Question: In a single sentence, describe what this figure presents.
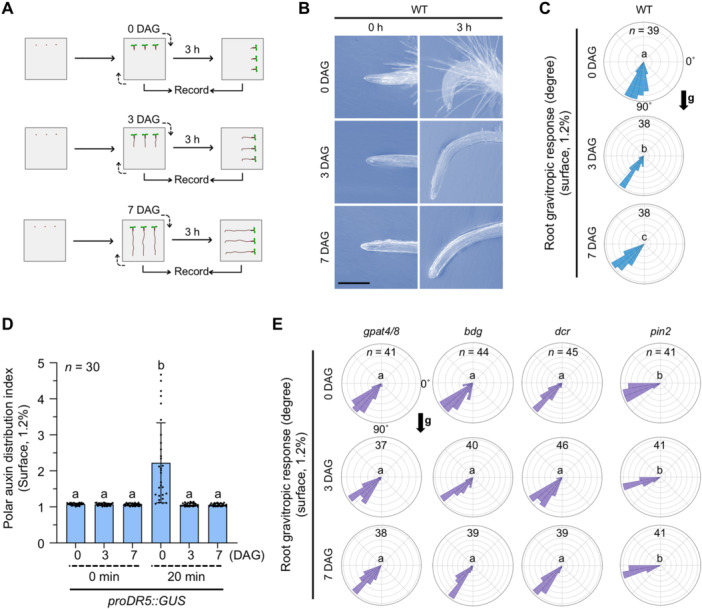
Answer: Root cap cuticle affects gravitropic response. (A) Schematic diagram of the reorientation experiment performed at 0, 3, and 7 DAG. (B, C) Representative images of root gravitropic responses before and 3 h after reorientation (B) and quantification of the gravitropic response (C) under the indicated conditions and time points ( n > 37 roots). Scale bar, 500 μm. (D) Quantification of relative auxin distribution in WT seedlings before reorientation and 20 min after a 90° gravistimulus. The degree of asymmetric proDR5::GUS signal distribution between opposing sides of the root was measured to assess auxin redistribution after reorientation ( n = 30 roots). (E) Quantification of gravitropic responses in the root cap cuticle mutants gpat4 gpat8 ( gpat4/8 ), bdg , and dcr , and in the gravitropic response mutant pin2 , under the indicated conditions and time points ( n > 36 roots). All experiments were repeated at least three times. Statistical analyses used Brown–Forsythe and Welch ANOVA with Dunnett's T3 post hoc test (C) and Kruskal–Wallis test with Holm correction followed by Dunn's post hoc test (D, E). Data are presented as circular histograms in (C, E) and as mean ± SD in (D). [Color figure can be viewed at wileyonlinelibrary.com ]